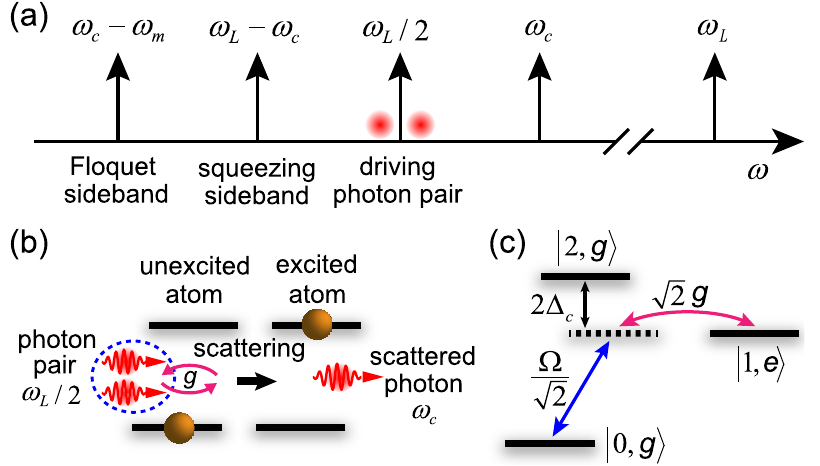
Figure 2: (a) Frequency-domain picture of a Floquet cavity driven by a weak and detuned parametric driving. The two-photon driving at frequency ω L , when driving the single-mode cavity of frequency ω c , can produce photon pairs at ω L /2 and induce a squeezing sideband at ω − ω L c . Owing to a cavity-frequency modulation with frequency driving photon pair interacting with an atom. If the squeezing sideband in (a) is tuned to the atomic resonance ω q , one photon of the photon pair at ω L /2 absorbs partially the energy of the other photon and is scattered into the cavity resonance ω c , and simultaneously the atom is excited by the remaining energy of the absorbed photon. (c) Transition mechanism responsible for Raman scattering described in (b). The weak, detuned two-photon driving ( Ω ) and the cavity mode ( g ) couple the states